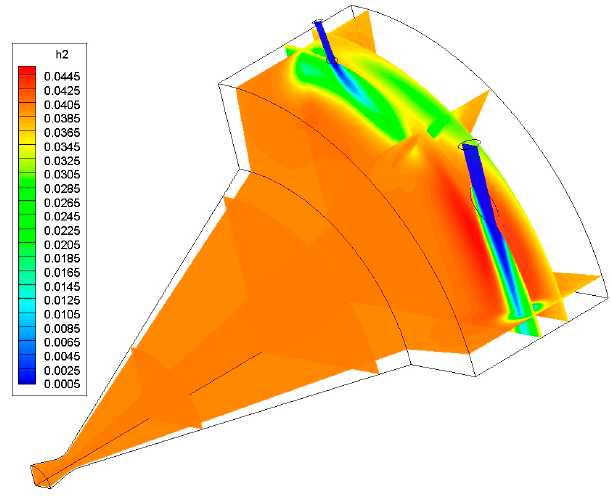
Figure 7. Hydrogen mass fraction distribution.